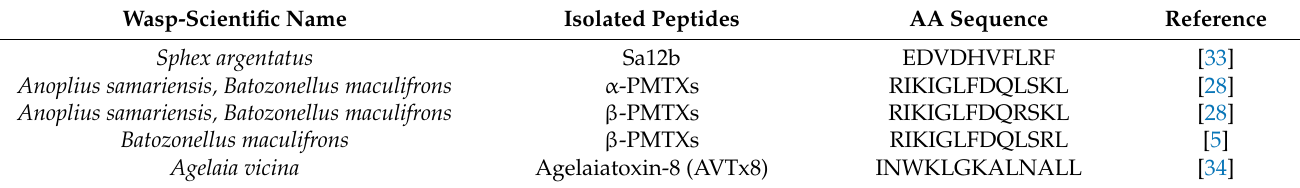
Table 1. Representative Neuropeptides from